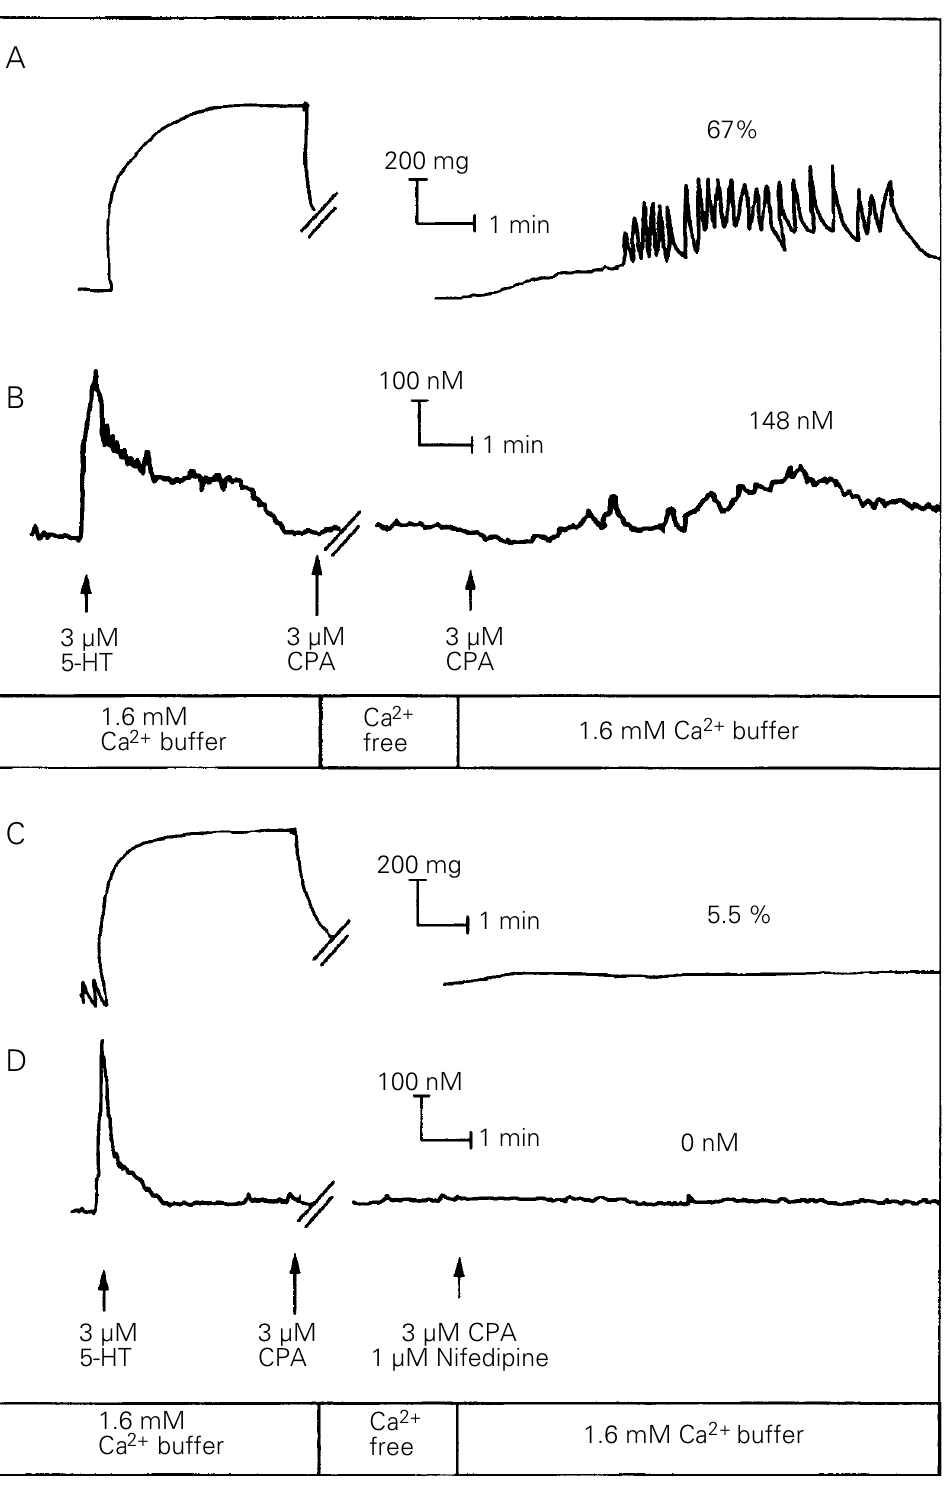
Figure 2 - Effects of nifedipine on CPA-induced contraction and the increase in [Ca 2+ ] i in DOCA aortic smooth muscle cells. The same protocol as described in the legend to Figure 1 was per- formed in aortas and isolated aortic myocytes from DOCA-hy- pertensive rats in the presence of 3 (cid:181)M CPA (A and B) or CPA plus 1 (cid:181)M nifedipine (C and D). Nifedipine inhibited both con- tractile responses and the in- crease in [Ca 2+ ] i during the Ca 2+ - loading period in DOCA aortic cells. Tracings are representa- tive of 6 experiments and values indicated in the figure were ob- tained from one of these experi-